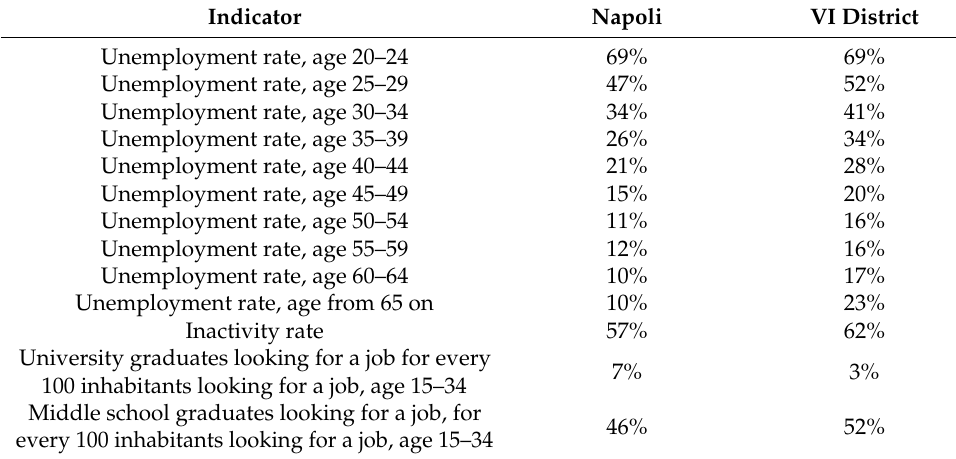
Table 1. The unemployment rate in VI District and Napoli *.